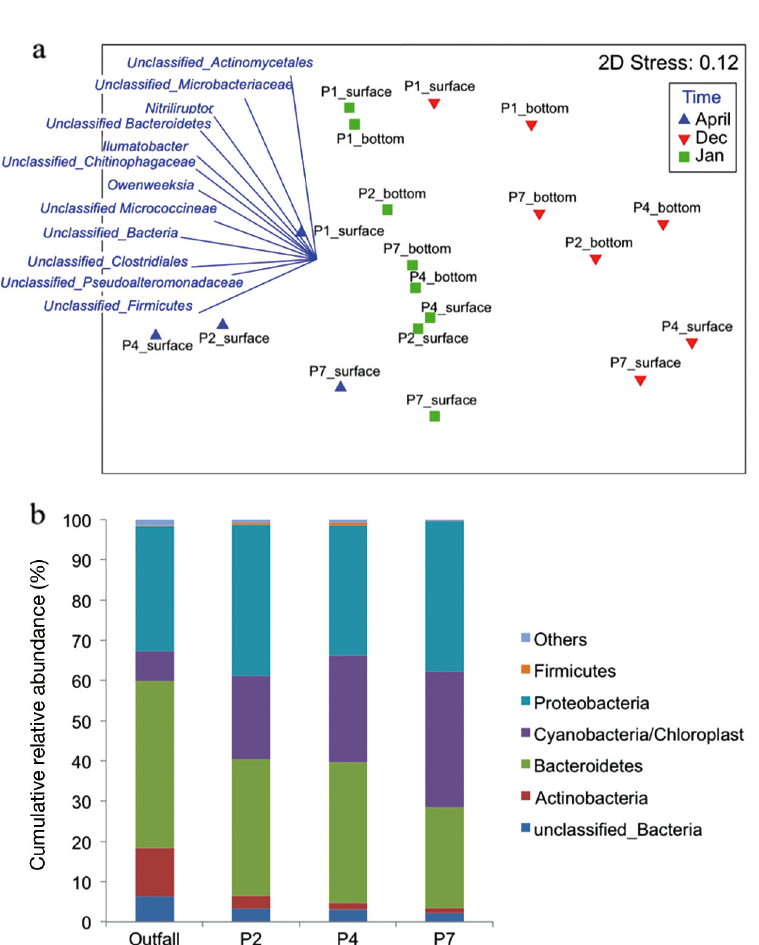
Fig. 9. (a) Multi-dimensional scaling plot based on Bray-Curtis dissimilari- ties of microbial communities among seasons (April, December, January) by station (P1 to P7, see Fig. 1) and water depth (surface and bottom wa- ter). Arrows indicate significantly correlated bacterial taxa; arrow length is proportional to the strength of the correlation. Data were square-root transformed. (b) Cumulative relative abundance of bacterial phyla